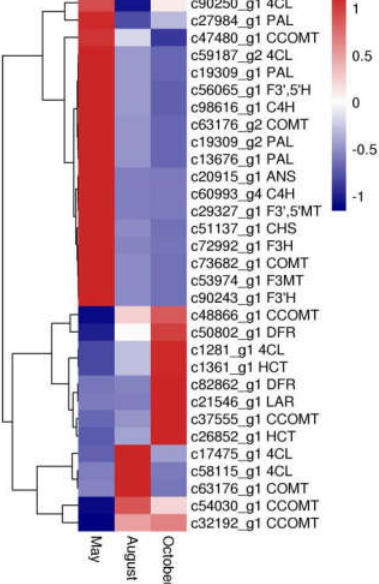
Figure 7. The expression patterns of DEGs involved in flavonoid biosynthesis. Blue and red colors represent different levels of gene expression and the color scales reflect a log 2 -transformed mean of fragments per kilobase of transcript per million mapped (FPKM) values.